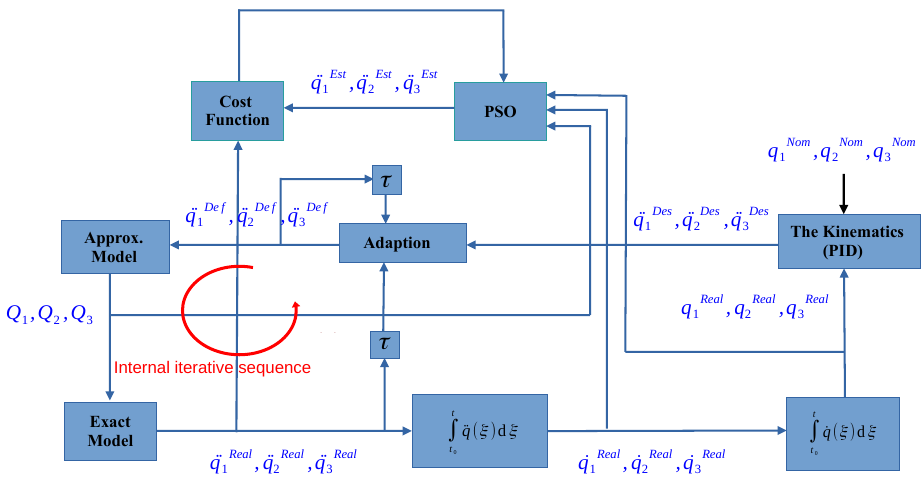
Figure 1. The PSO’s operation flow chart. The PSO block takes the information from the real- ized coordinates q Real , q Real , q Real , their first time derivatives ˙ q Real 2 3 1 torque components Q 1 , Q 2 , Q 3 so that it can calculate their estimated second time derivatives ¨ q Est , ¨ q Est , ¨ q Est . These estimated values will be evaluated and compared with the realized second 2 3 1 derivatives ¨ q Real , ¨ q Real , ¨ q Real via the cost function defined as Cost = ∑ i | ¨ q Real 2 3 1 process of PSO handles to search journey toward the global minimum in respect of the defined particles that can be found in Section 4. The dynamics of the PSO-based parameter tuning is not coupled to that of the adaptive control, in contrast to the operation of the classic tuning methods. The iterative sequence of the FPI-based adaptive controller is formed within the loop as indicated in the chart by a red